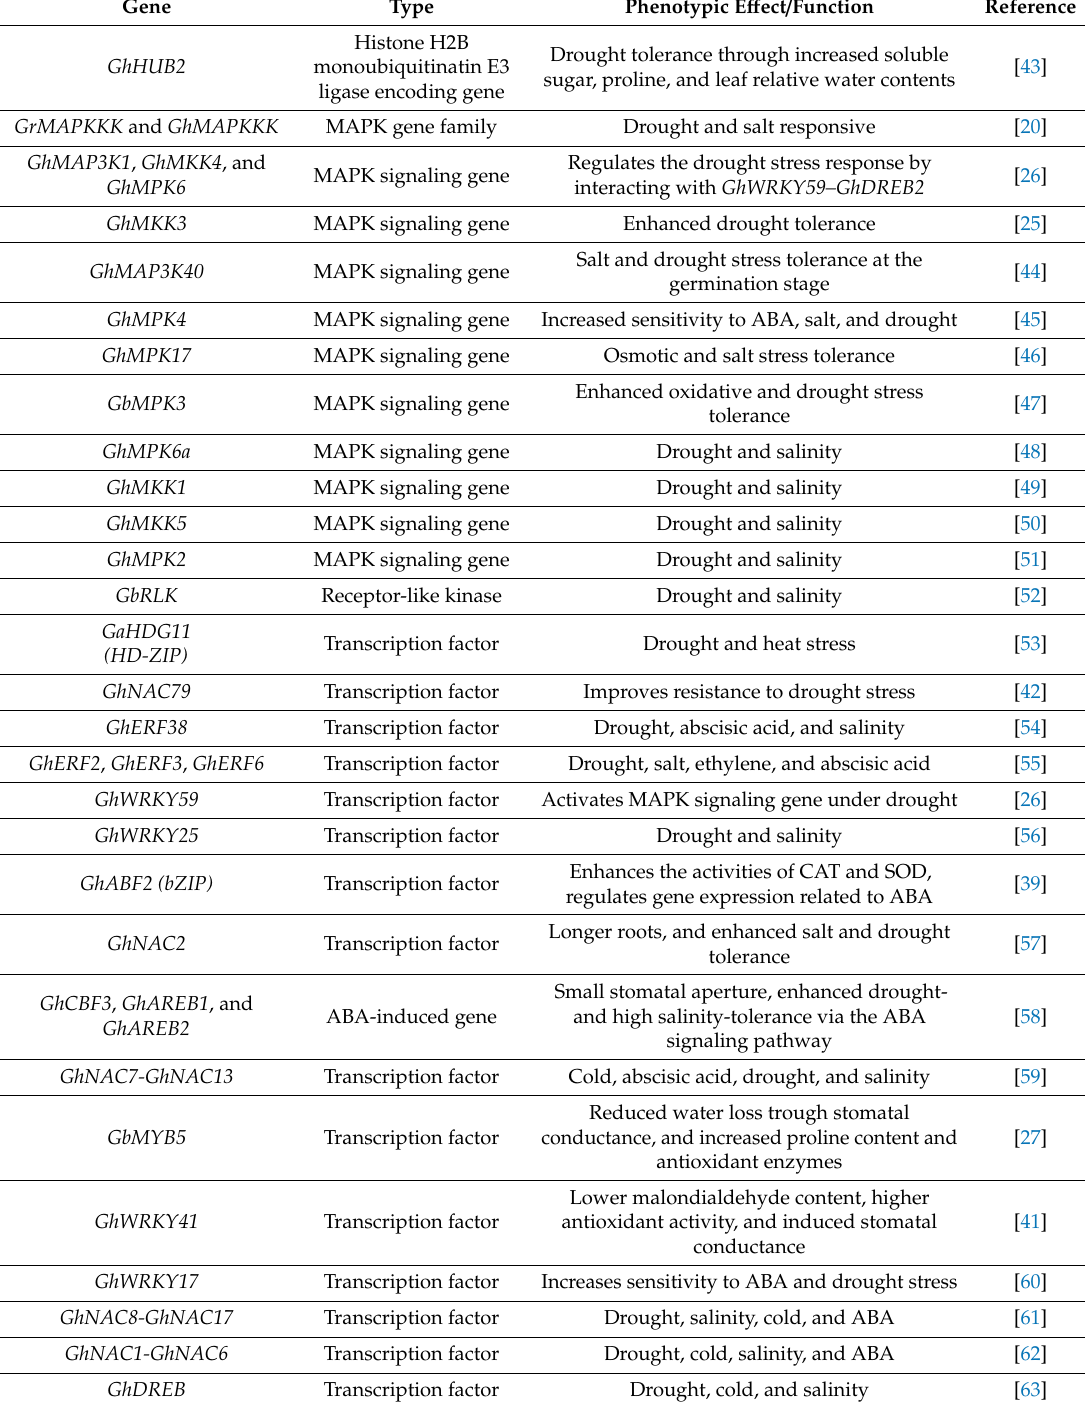
Table 1. Key genes involved in abiotic stress signaling in rolling